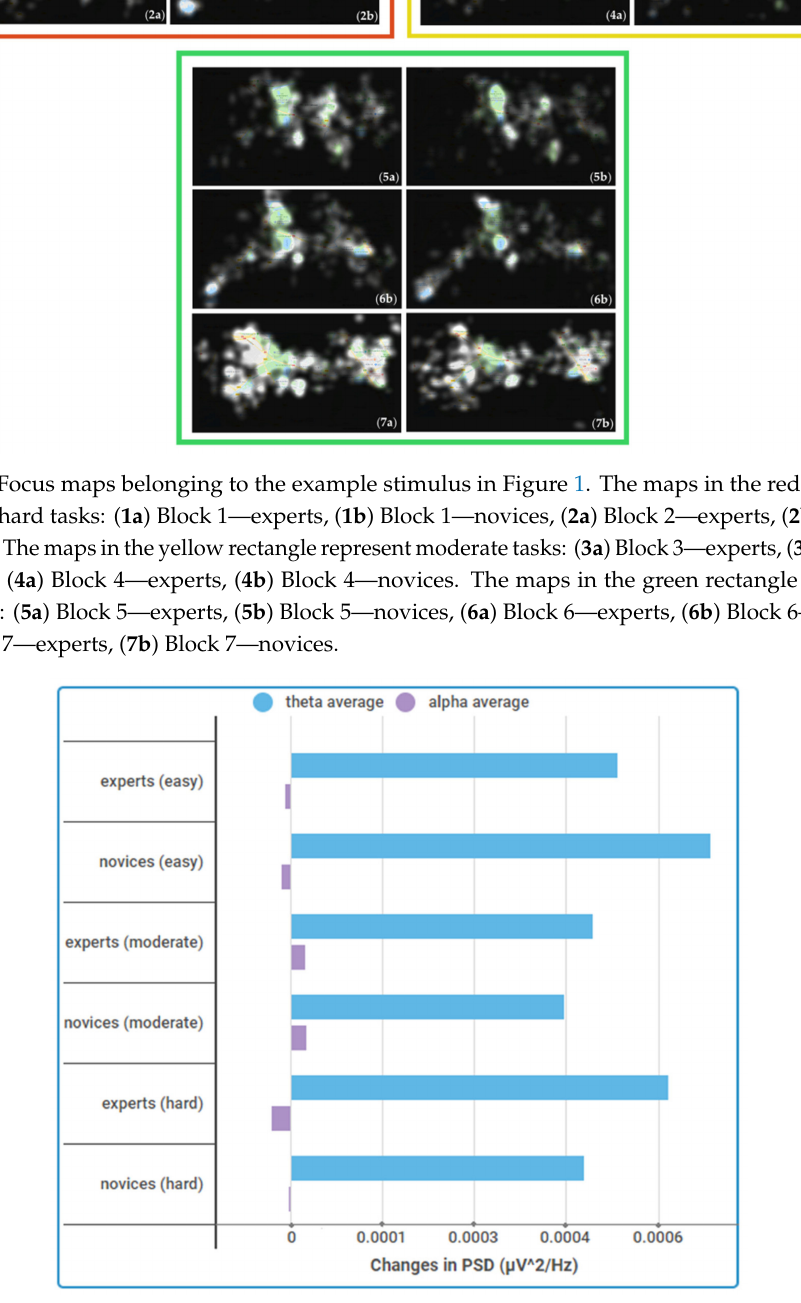
Figure 7. Changes in power spectral density (PSD) of alpha and theta for experts and novices ( µ V 2 / Hz) (Alpha values are multiplied by 10 for visualization